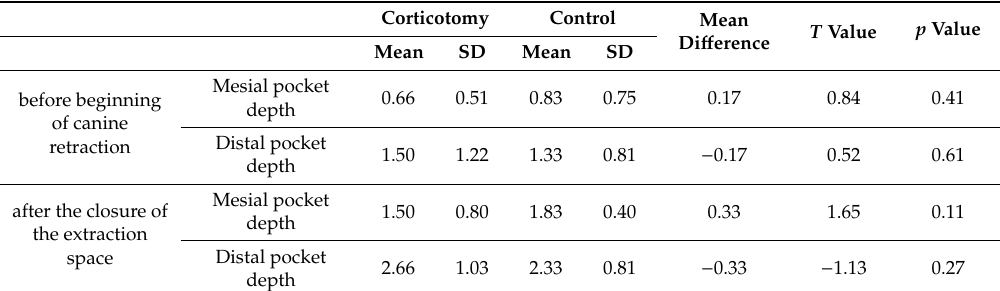
Table 7. Comparison of pocket depth in both sides before treatment and after closure of the extraction